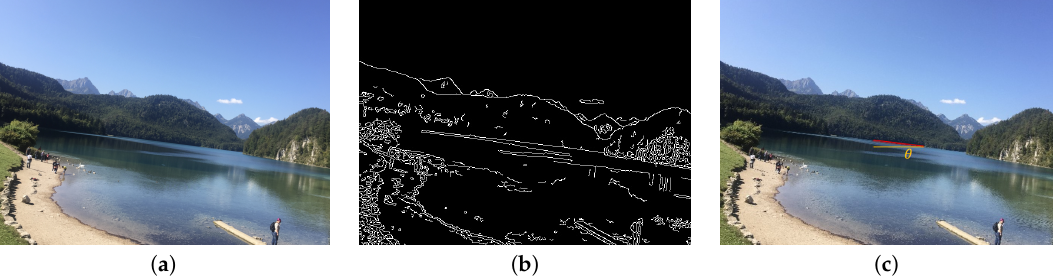
Figure 4. ( a ) Original figure. ( b ) Edge detection results. ( c ) The longest line and its corresponding angle, as shown near the center of the image.